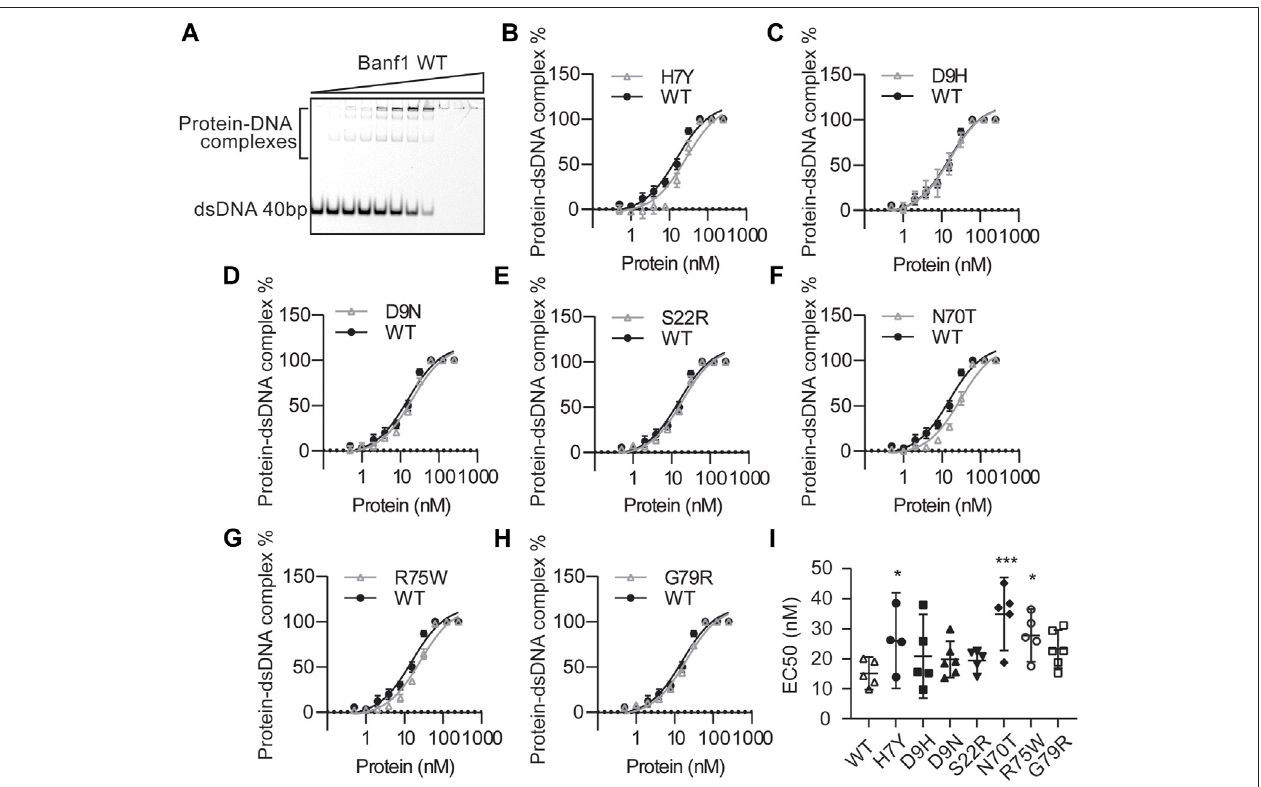
FIGURE3| Banf1variantsdisplay differingdsDNA bindingaf fi nities. (A) Representative electrophoresis mobilityshiftassay(EMSA) ofBanf1WT (0.5,1.0, 2.0,3.9, 7.8, 15.6, 31.3, 62.5, 125, 250 nM) binding to dsDNA of 40bp labelled with 5 ′ Cy5. EMSA comparing percentage ofBanf1 WT withBanf1variant (B) H7Y , (C) D9H, (D) D9N, (E) S22R, (F) N70T, (G) R75W, (H) G79R binding to dsDNA. Curves were fi tted with non-linear regression model and plotted with a logarithmic x -axis. (I) EC50 quanti fi cation of Banf1 variant-dsDNA binding derived from least four independent experiments. Error bars denote 95% con fi dence intervals as determined by the binding curve fi tting is shown. * p < 0.05; ** p < 0.01, *** p <